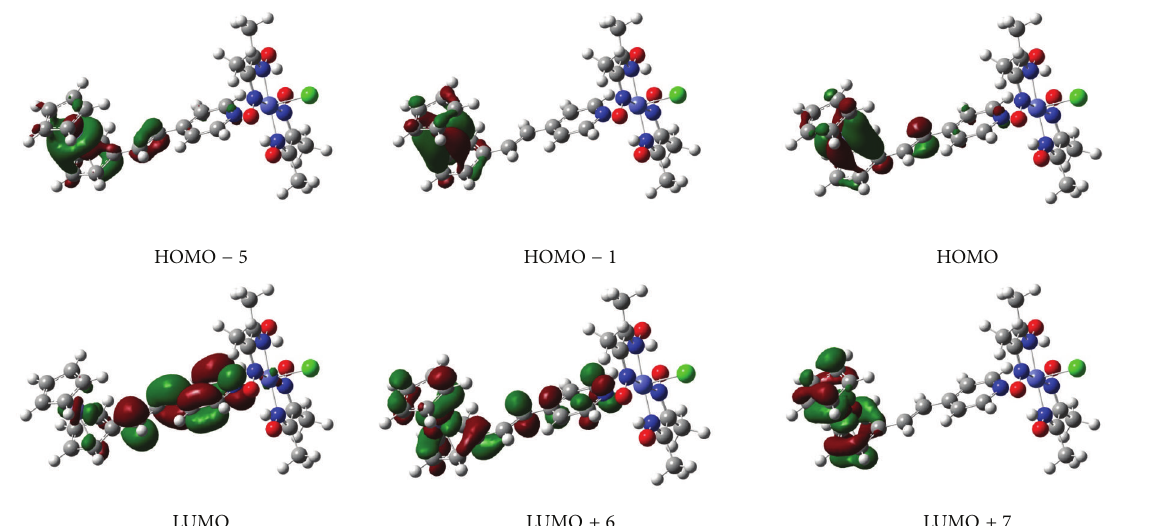
Figure 2: Surfaces of the molecular orbitals involved in the transitions of the [CoCl(dmgH) 2 (fcvpy)] absorption spectrum.